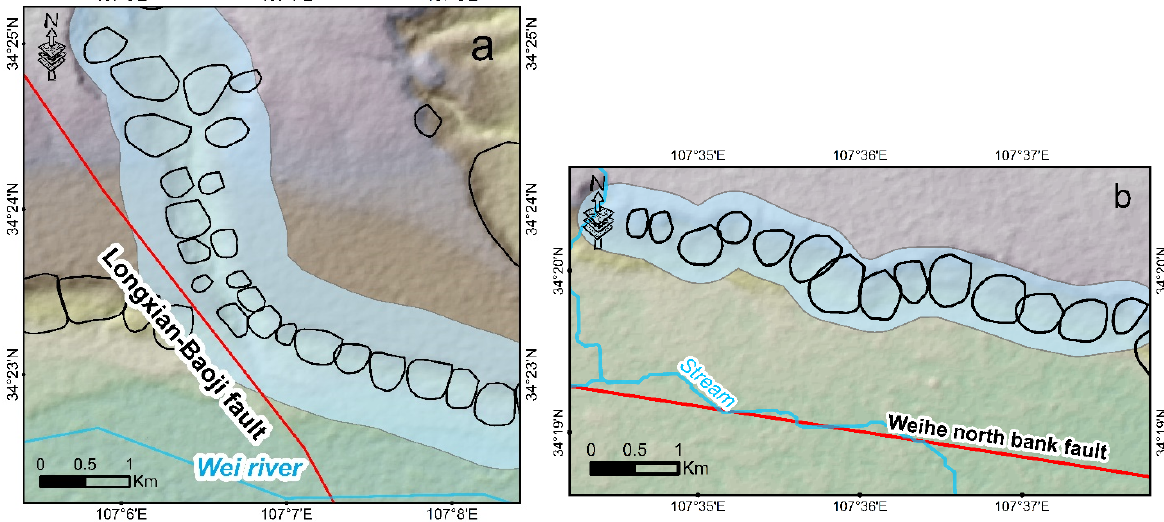
Figure 14. Typical ‘landslide zone’ in the study area. The black irregular polygon represents a single landslide, and the light blue area represents a concentrated landslide development zone. The locations of ( a , b ) are shown in Figure 11.